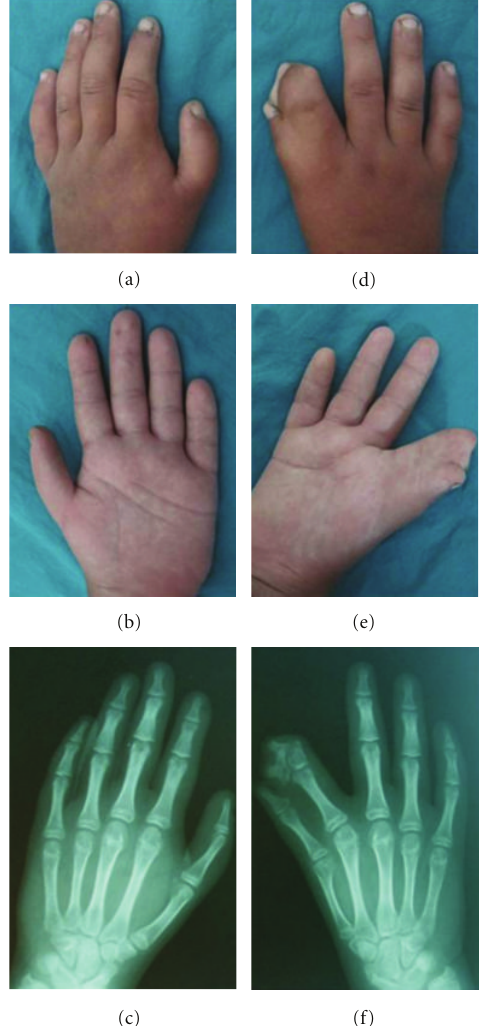
Figure 6: Limb abnormalities in the patient’s uncle. Hands photographs and radiographs showing (a)–(c) hypoplastic thumb in the left hand and (d)–(f) syndactyly between the first and second fingers, with an extra nail in the right